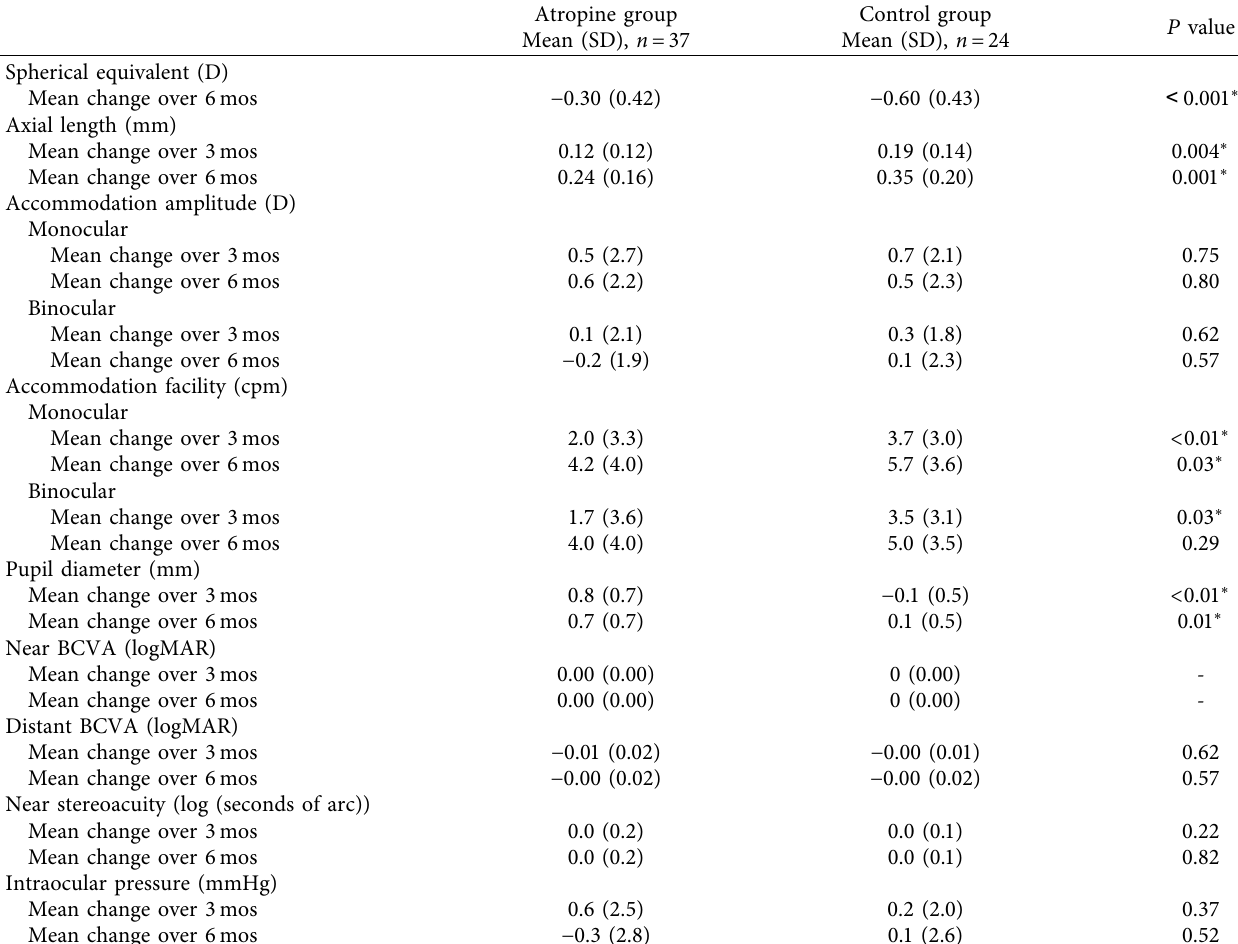
Table 3: Ophthalmological parameters at follow-up